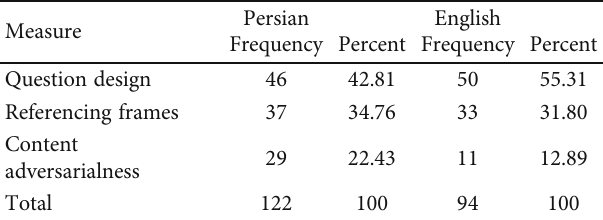
Table 3: Frequency of question type in Persian and English.